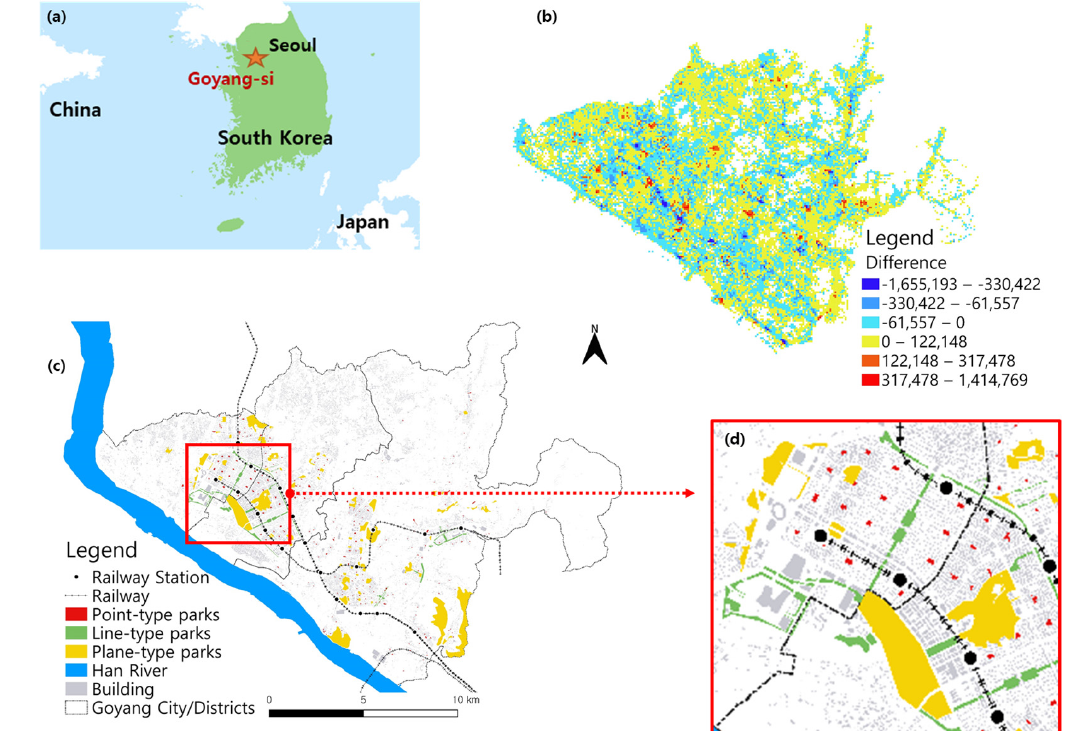
Figure 1. ( a ) Location of the study area, Goyang City, near Seoul, South Korea; ( b ) Distribution of the increase/decrease in the floating population affected by COVID-19 pandemic within the study area; ( c ) Distribution of the locations of urban parks within the study area showing the different types of urban parks on a clear display; ( d ) An enlargement of part of Figure 1.